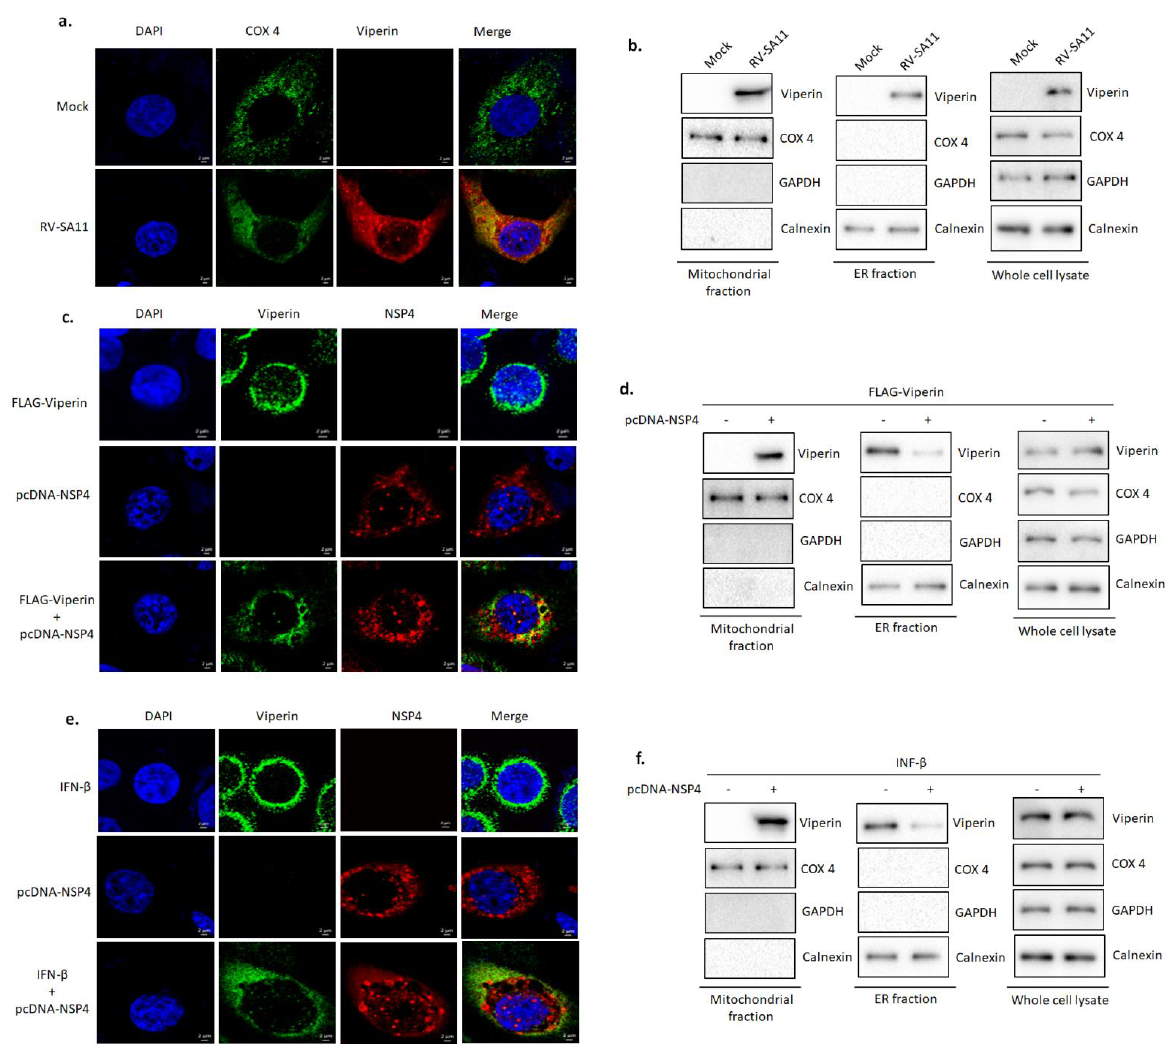
Figure 4. Viperin was relocalized from the ER to the mitochondria, triggered by RV-NSP4. ( a ) HT-29 cells were either mock infected or infected with RV-SA11 and incubated for 9 h. Next, cells were fixed, permeabilized and stained with anti-COX 4 and anti-viperin primary antibodies. Secondary staining was performed with Dylight488-labeled anti-mouse (for COX 4) and rhodamine-labeled anti-rabbit (for viperin) antibodies. DAPI was used for mounting. Imaging was done with a confocal microscope (63X oil immersion). Scale bar, 2 µ m. ( b ) HT-29 cells were either mock infected or infected with RV-SA11 at an MOI of 3 for 9 h. Cells were harvested and used to prepare the mitochondrial fraction, the ER fraction and the whole-cell lysate. Next, the mitochondrial fraction, the ER fraction and the whole cell lysate were subjected to SDS-PAGE/western blot analysis to check the expressions of viperin, COX 4, calnexin and GAPDH. COX 4 and calnexin were used as the mitochondrial marker and the ER marker, respectively. GAPDH was used as the cytoplasmic marker to rule out cross contamination of the mitochondrial fraction and the ER fraction with cytosol. ( c ) HT-29 cells were transfected with FLAG-viperin, pcDNA-NSP4 or both FLAG-viperin and pcDNA-NSP4 and incubated for 36 h. Next, cells were fixed, permeabilized and stained with anti-viperin and anti-NSP4 antibodies. Secondary staining was done with Dylight488-labeled anti-mouse (for viperin) and rhodamine-labeled anti-rabbit (for NSP4) antibodies. DAPI was used for mounting. Imaging was performed with a confocal microscope (63X oil immersion). Scale bar, 2 µ m. ( d ) HT-29 cells were transfected with either pcDNA-NSP4 or both pcDNA-NSP4 and FLAG-viperin and incubated for 36 h. After incubation, the mitochondrial fraction, the ER fraction and the whole cell lysate were prepared and subjected to western blot to check expressions of viperin, COX 4, calnexin and GAPDH. ( e ) HT-29 cells, either treated with IFN- β (6 h) or transfected with pcDNA-NSP4 or both transfected with pcDNA-NSP4 and treated with IFN- β were subjected to confocal microscopy as described in section c. Scale bar, 2 µ m. ( f ) HT-29 cells, transfected with either pcDNA-6B or pcDNA-NSP4, were treated with IFN- β for 6 h. After incubation, the mitochondrial fraction, the ER fraction and the whole-cell lysate were prepared and subjected to western blot to check expressions of viperin, COX 4, calnexin and